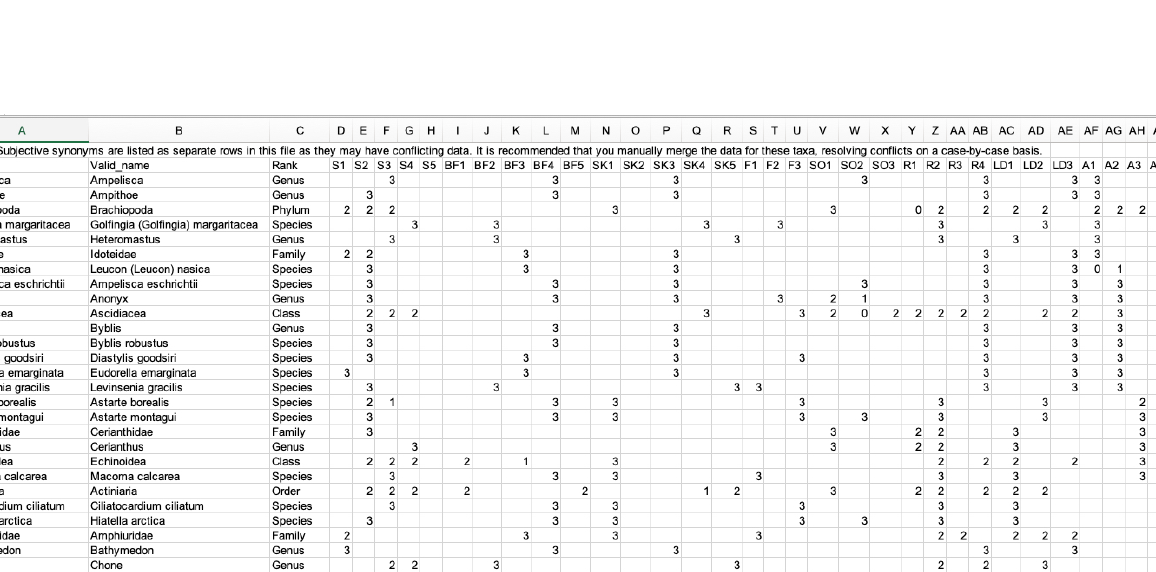
Figure 5. A screenshot from the fuzzy coded trait matrix returned by the Arctic Traits Database when the “Data in matrix format” is chosen as export option from the download section. Species are rows (“Valid_name” refers to the currently accepted taxonomy in WoRMS), and abbreviated trait categories are columns. For abbreviations of trait categories, see Table 3. Due to the database structure, zero codes (“0”) are not displayed (see Table